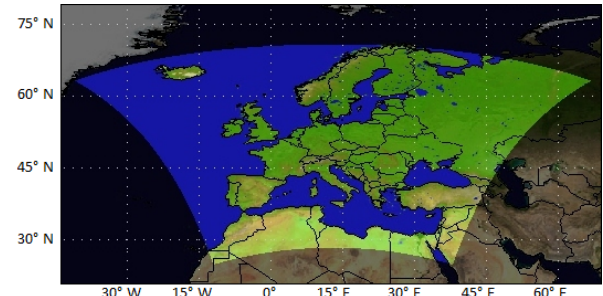
Figure 1. Position of the model domain in regular longitude- latitude